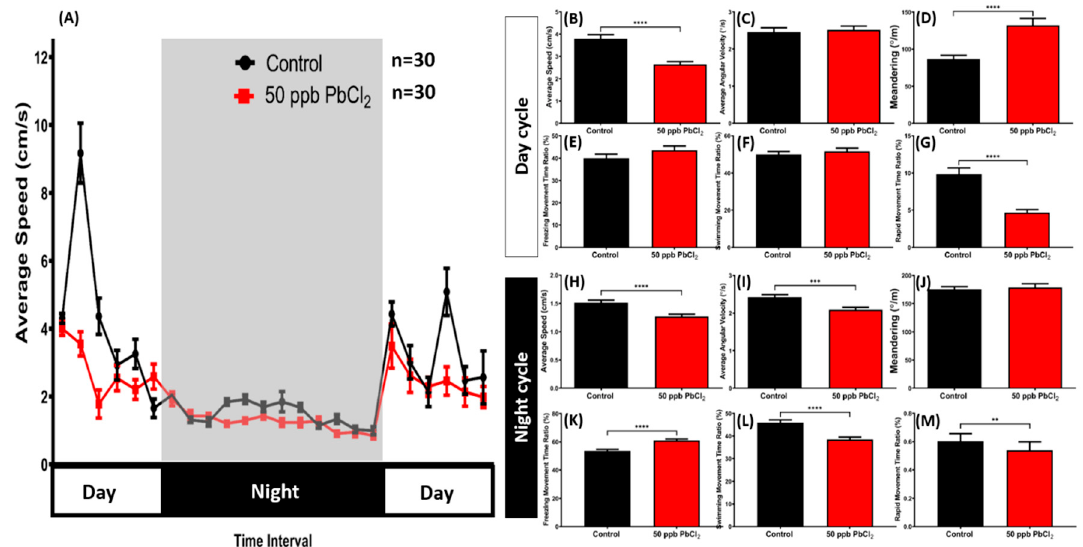
Figure 6. Evaluation of the circadian rhythm locomotor activity for control and chronic PbCl 2 -treated fish (50 ppb, red). ( A ) Circadian locomotor activity patterns of average speed; ( B ) average speed; ( C ) average angular velocity; ( D ) meandering; ( E ) freezing movement time ratio; ( F ) swimming movement time ratio; and ( G ) rapid movement ratio during the light cycle; ( H ) average speed; ( I ) average angular velocity; ( J ) meandering; ( K ) freezing movement time ratio; ( L ) swimming movement time ratio; and ( M ) rapid movement ratio during the dark cycle. The data are expressed as mean ± SEM and analyzed by the Mann–Whitney Test ( n control fish = 18; n PbCl 2 -treated fish = 18; ** p < 0.01, *** p < 0.001, **** p < 0.0001).